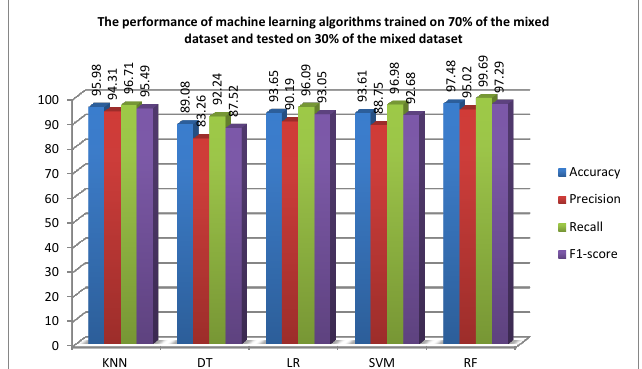
Figure 10. The performance of the supervised machine learning algorithms trained on 70% of the mixed dataset and tested on 30% of the mixed